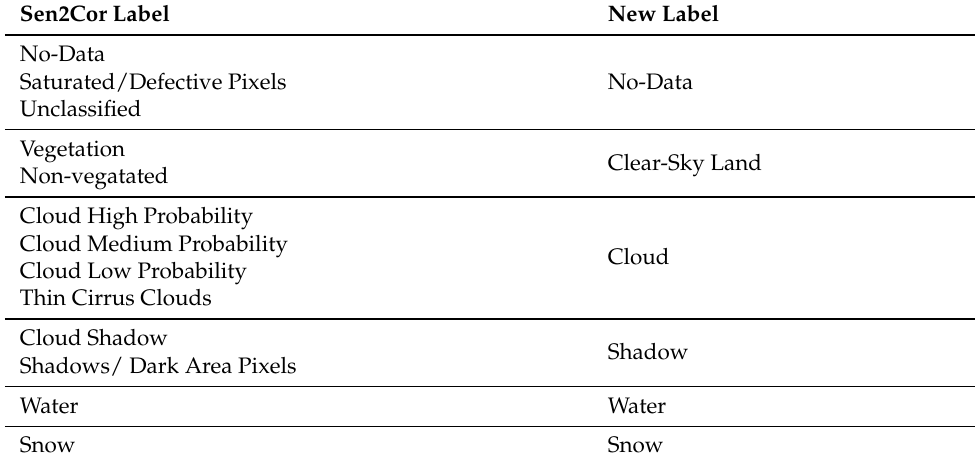
Table 2. Regrouping of Sen2Cor labels. Sen2Cor Label New